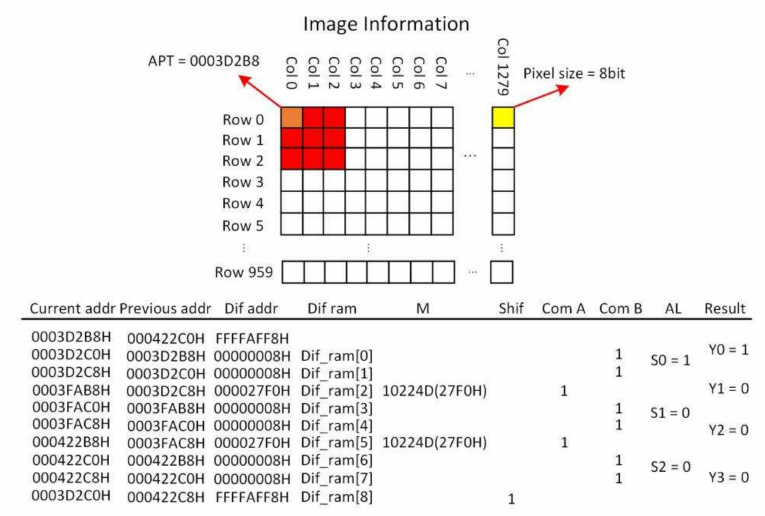
Figure 7. Detailed example of access by the stream access prediction